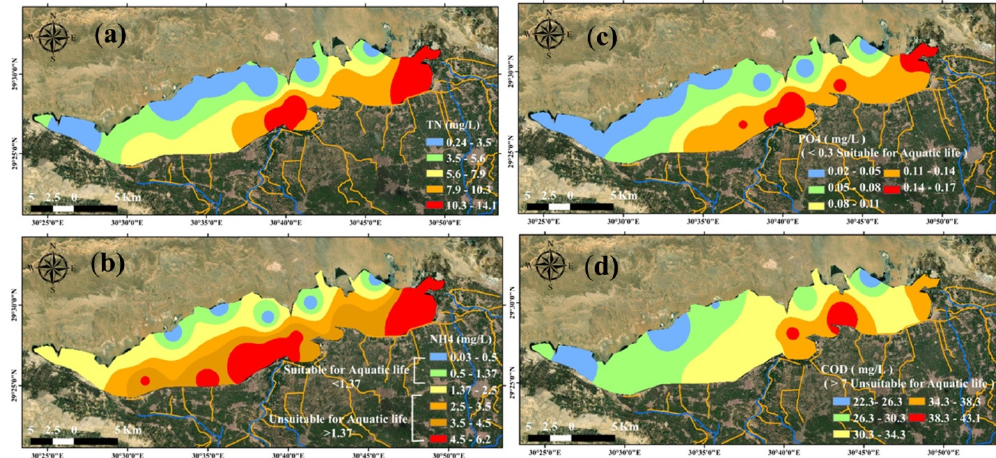
Figure 2. WQPs spatial distribution maps of in 2018: ( a ) total nitrogen (TN), ( b ) ammonium (NH 4+ ), ( c ) orthophosphate PO 43 − , and ( d ) chemical oxygen demand (COD).